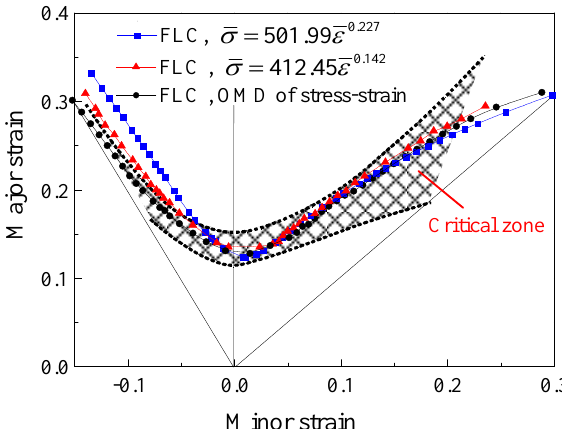
ff erent stress–strain